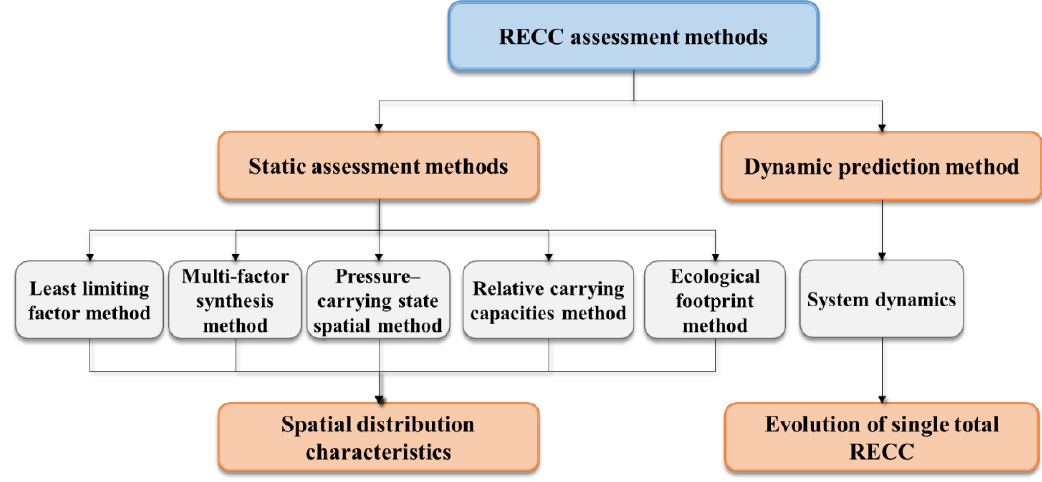
Figure 3. RECC assessment